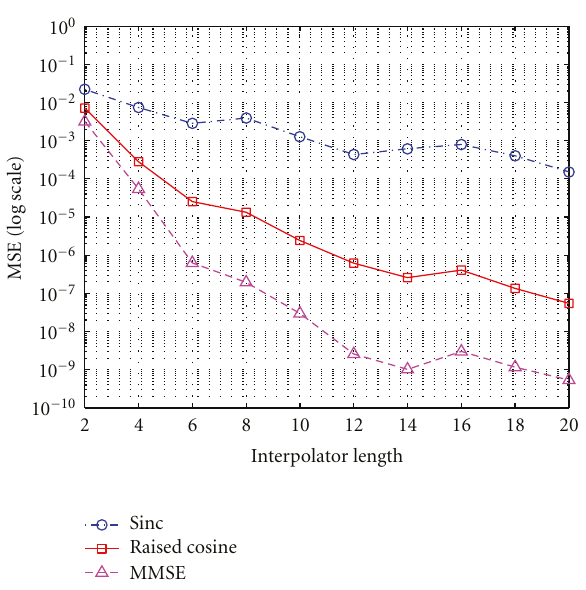
Figure 6: MSE versus truncation length for time o ff set μ = 0 . 5.